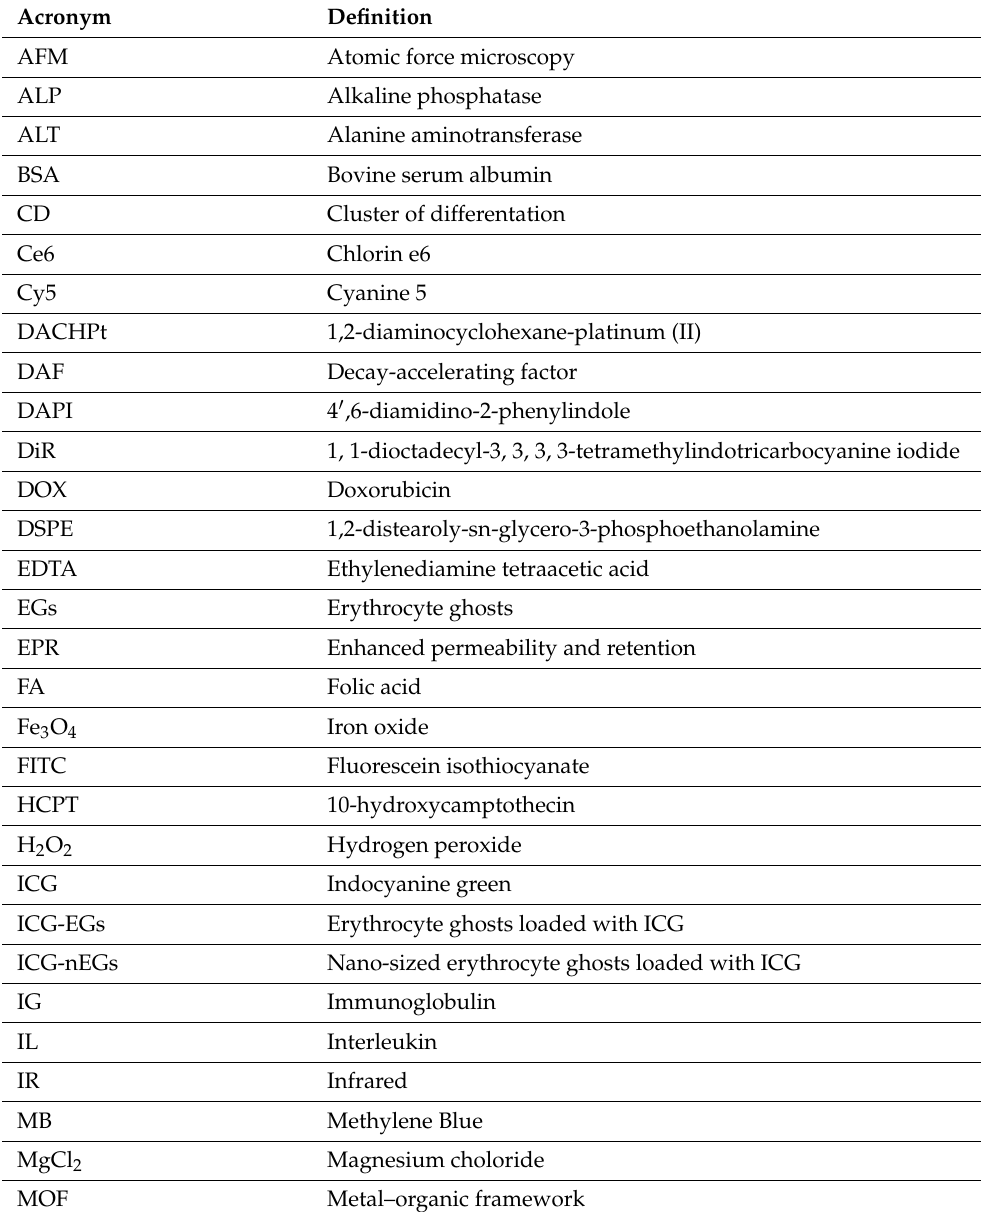
Table 1. List of